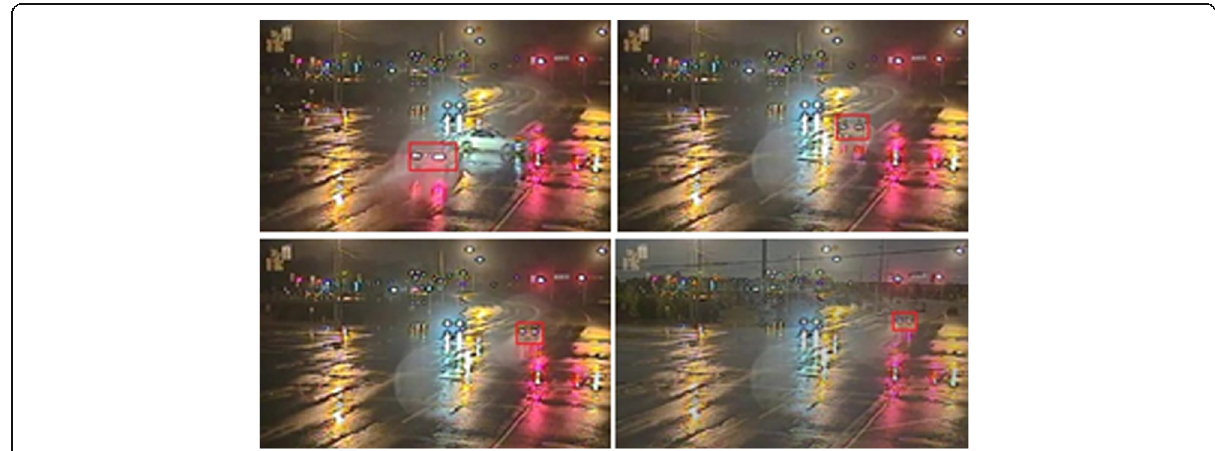
Fig. 25 Target tracking results under low contrast of background (images are from left to